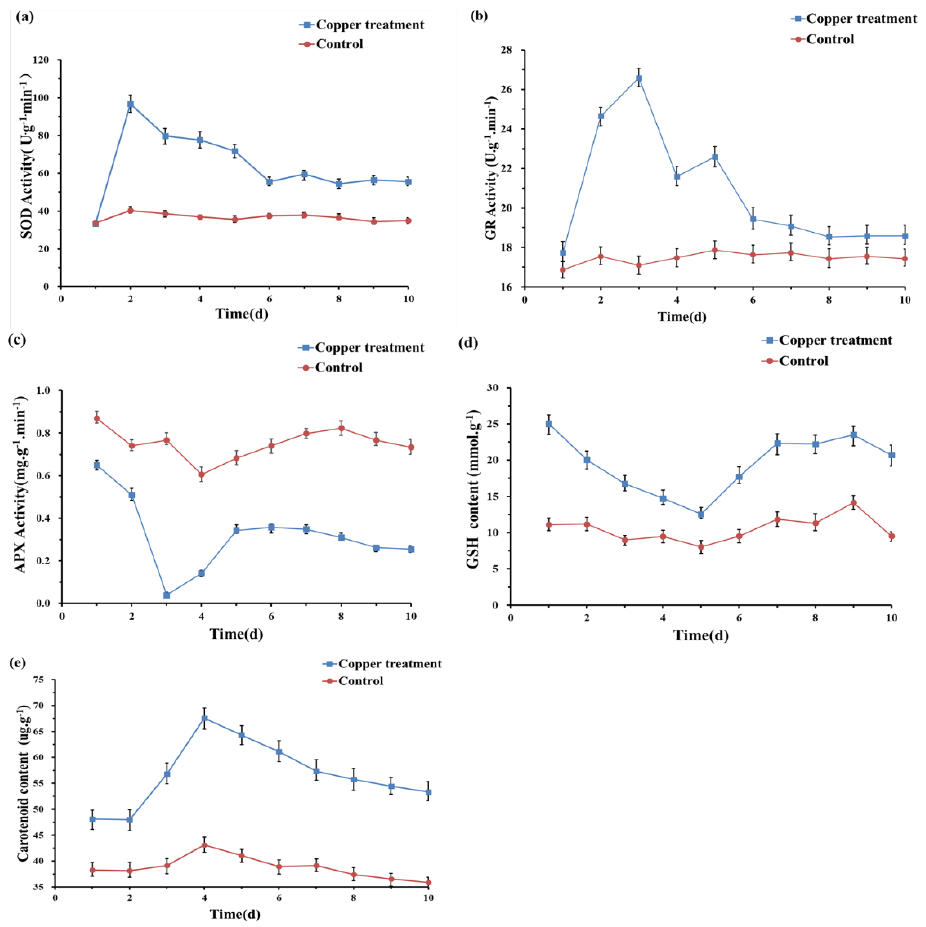
Figure 2. Effects of 0.5 mmol/L Cu 2+ on the activities of SOD ( a ), GR ( b ), APX ( c ), GSH ( d ), and Carotenoid ( e ) of Planococcus sp. O5.